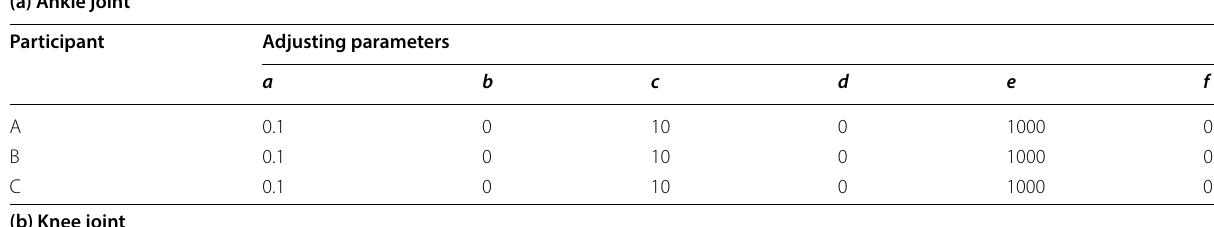
Table 4 Adjusting parameters of NBS in the running experiment (a) Ankle